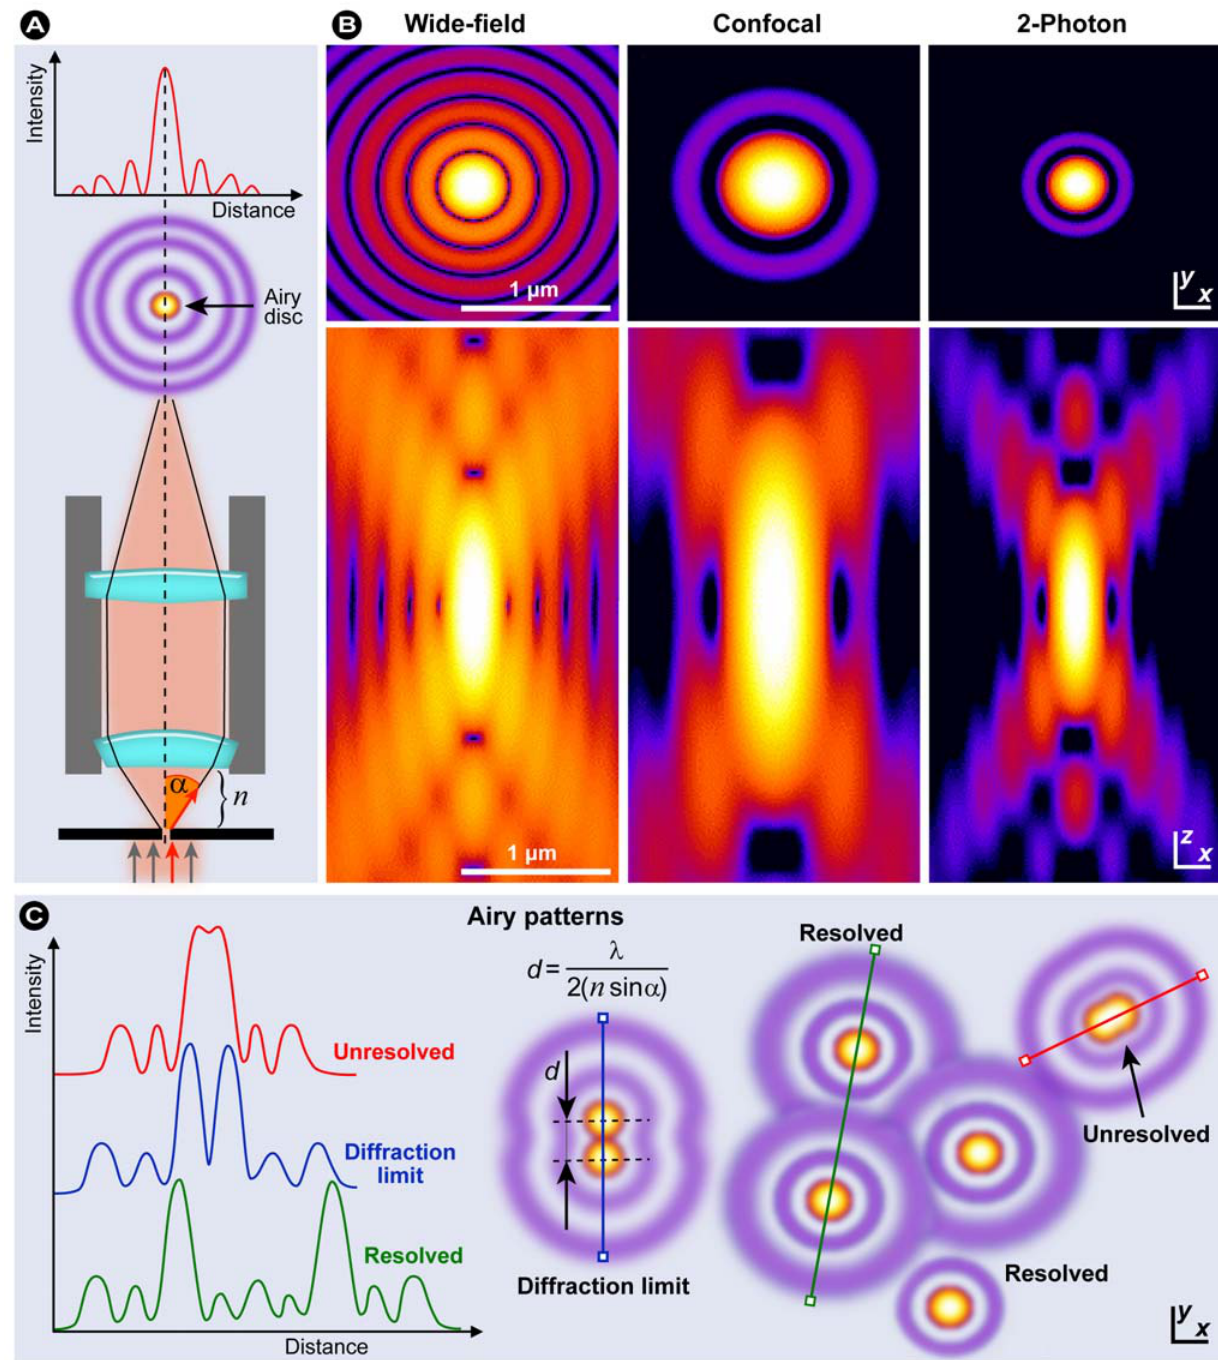
Figure 7. ( A ) Objective and light beam path: a point source in the focal plane is imaged and projected as a bright central spot (Airy disc) and a concentric ring pattern (Airy pattern) that results from diffraction. ( B ) Calculated x-y (above) and x-z (below) intensity distributions (logarithmic scale) for a point source imaged with various microscopical = 488 nm and 900 nm for 1PE and 2PE, respectively; techniques. Optical conditions:  ex = 520 nm; N.A. = 1.3 for an oil immersion objective with oil refractive index value set  em at 1.515. Reproduced from [45]. © 2006 BioMed Central. ( C ) Schematic diagram of an Airy disc diffraction pattern : Abbe diffraction limit, contrast, and optical